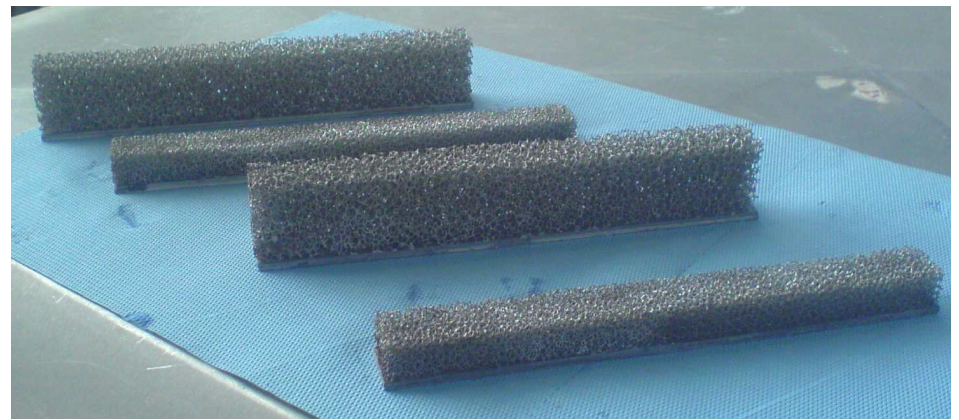
Figure 12. Several foam heat sinks made in-house and used as validation for the VAT model.